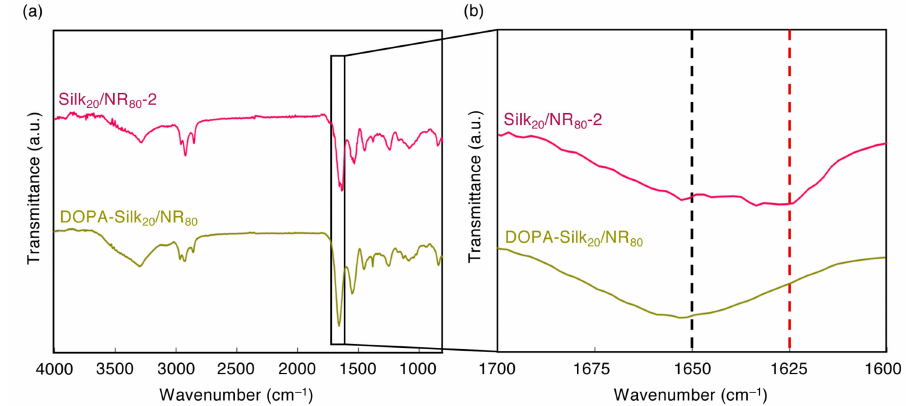
Figure 13. ATR-FTIR spectra of silk 20 / NR 80 -2 and DOPA-silk 20 / NR 80 in the range of ( a ) 4000–800 cm –1 and ( b ) 1700–1600 cm –1 . The black dotted line (1650 cm − 1 ) represents the amide I absorption of the random coil structure of silk, while the brown dotted line (1625 cm − 1 ) represents that of the β -sheet structure [54].